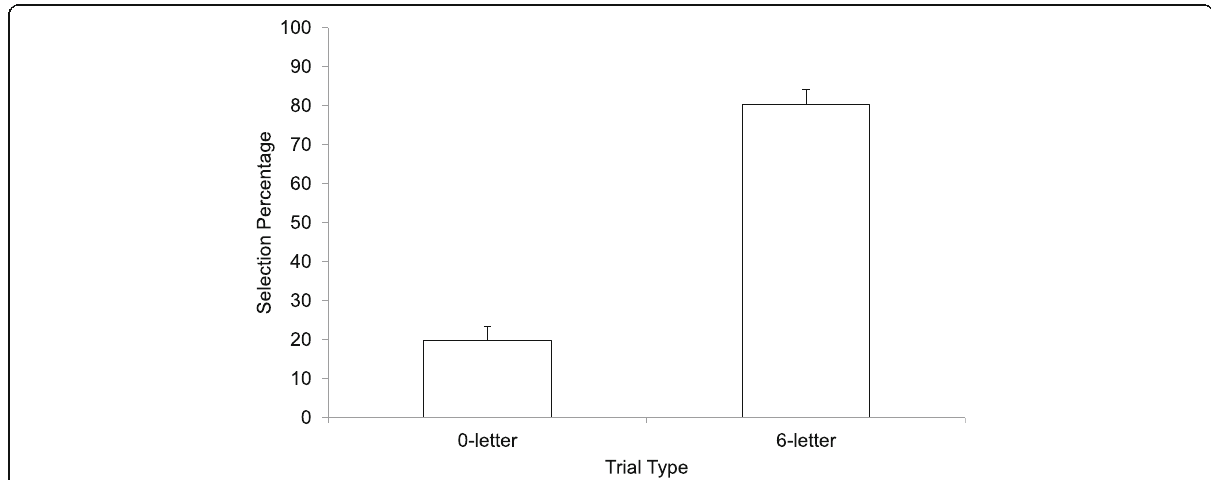
Fig. 2 Selection rate (reported as a percentage) as a function of trial type in Experiment 2. Error bars report standard error of the